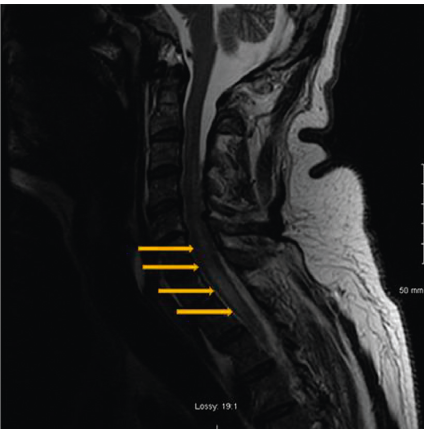
Figure 2: A sagittal T-weighted MRI of the C-spine of the patient on May 22, 2017, after the antifungal treatment. The arrows point to the spinal cord lesion due to coccidioidal infection; however, the size of the lesion has decreased significantly in comparison to Figure